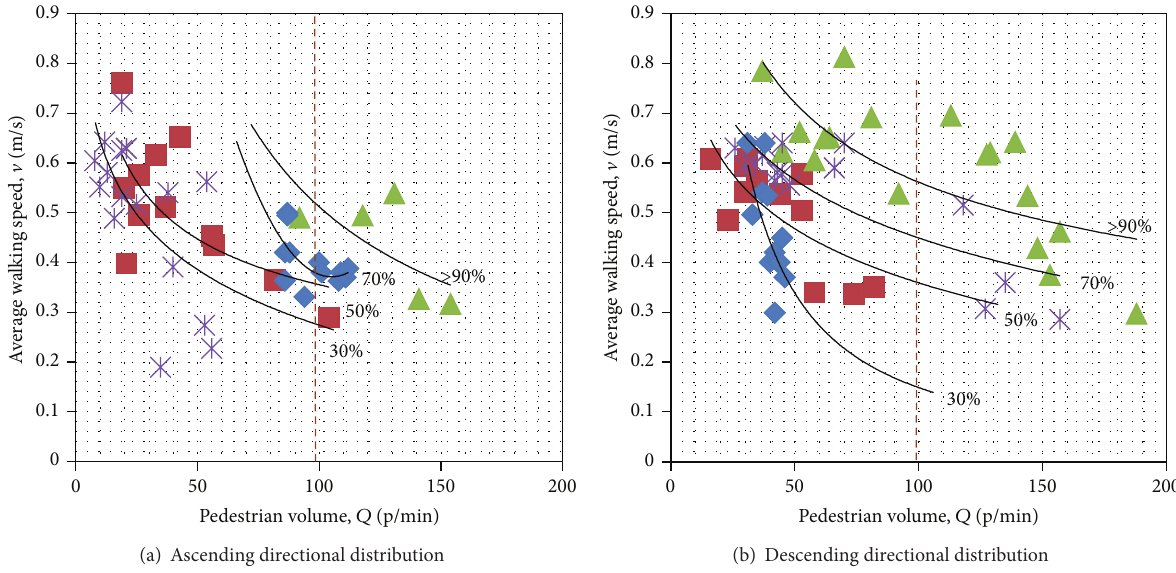
Figure 10: Percentage distributions in ascending and descending Direction.